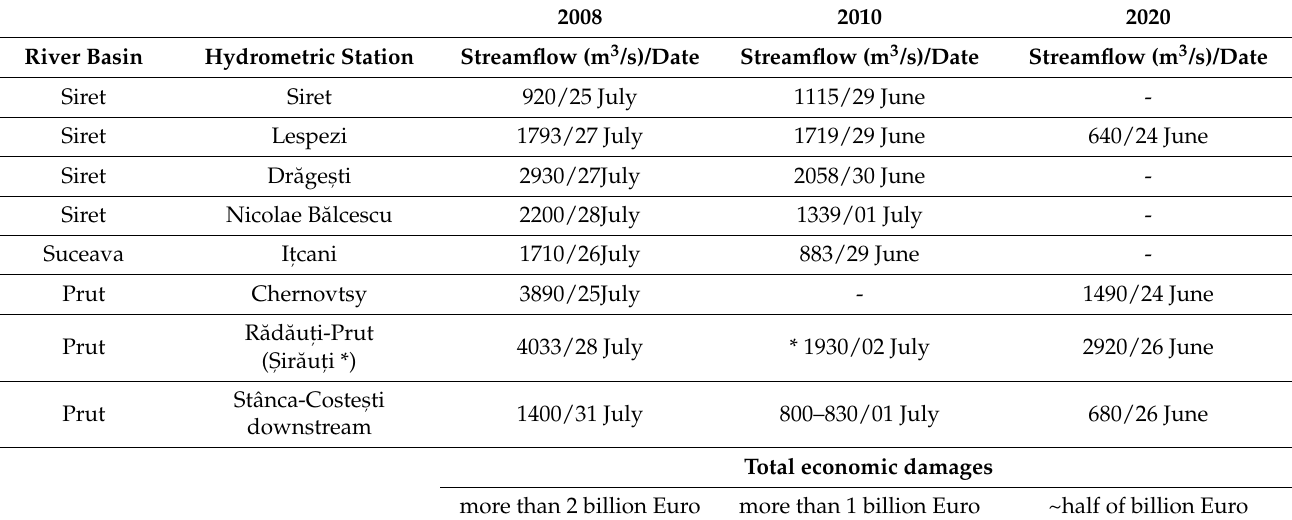
Table 1. Maximum streamflow recorded at different hydrometric station on Siret and Prut Rivers for 2008, 2010, and 2020 floods, and their total economic